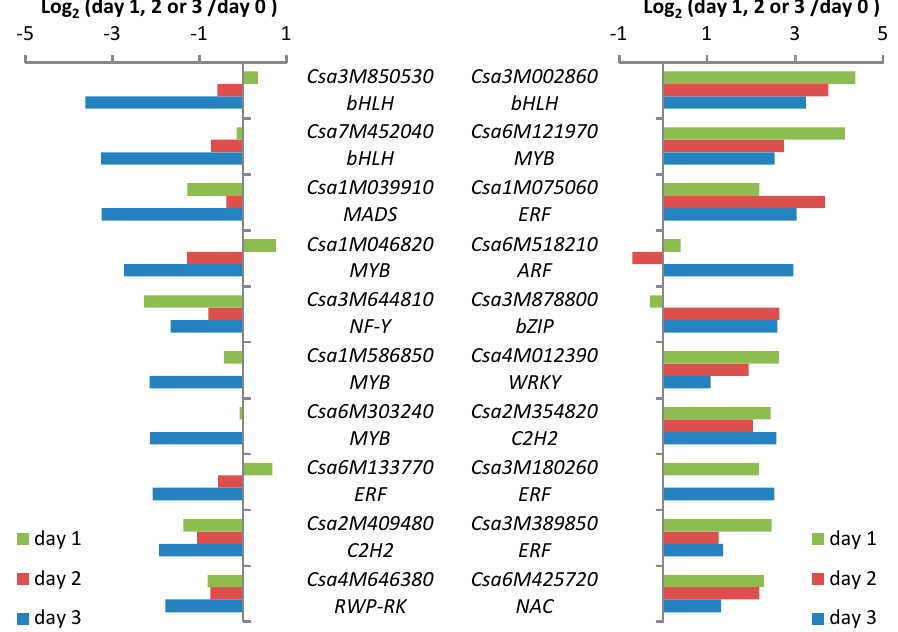
Figure 4. Top 10 strongest down- and up-regulated transcription factor genes in cucumber accession Chinese long after one, two or three days of spider-mite feeding.